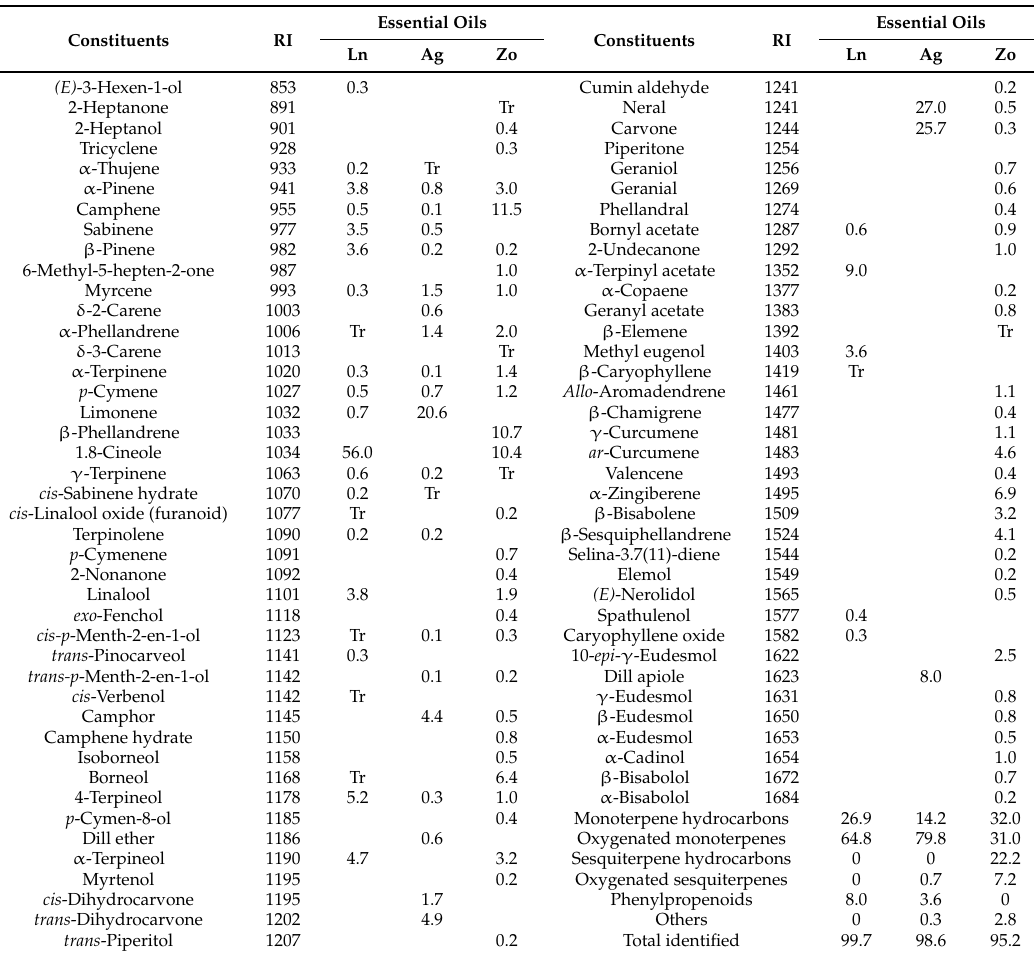
Table 2. Composition of L. nobilis (Ln), A. graveolens (Ag) and Z. officinale (Zo) essential oils. RI: Retention Index; Tr: Traces (less than 0.5%). Constituents